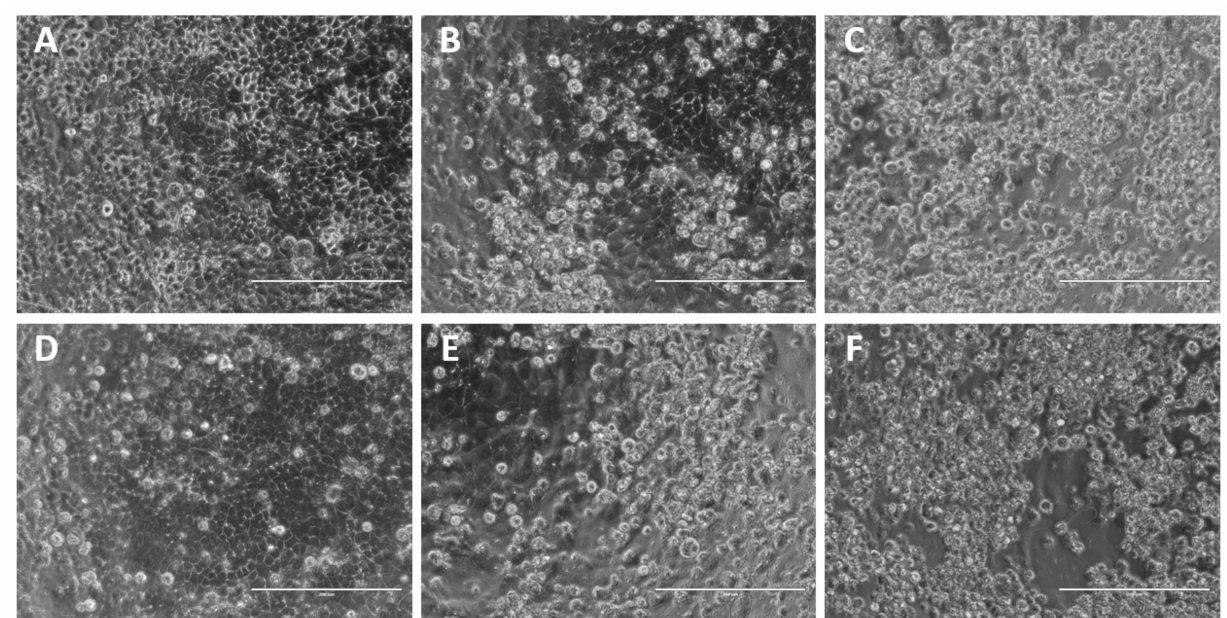
Figure 9. Representative images showing viral CPE of A/Singapore/G2-31.1/2014 in the microneu- tralization assays at 3 dpi. Images depict cells tested with serum samples FMK041 ( top row ) and FMT486 ( bottom row ). Microscopic images were captured using the EVOS XL microscope at 20 × magnification. The scale bar ( bottom right ) represents 200 µ m. “Serum-only” controls are shown in ( A , D ). MDCK-SIAT1 cells were infected with either P0 viral supernatant ( B , E ) or P5 viral super- natant ( C , F